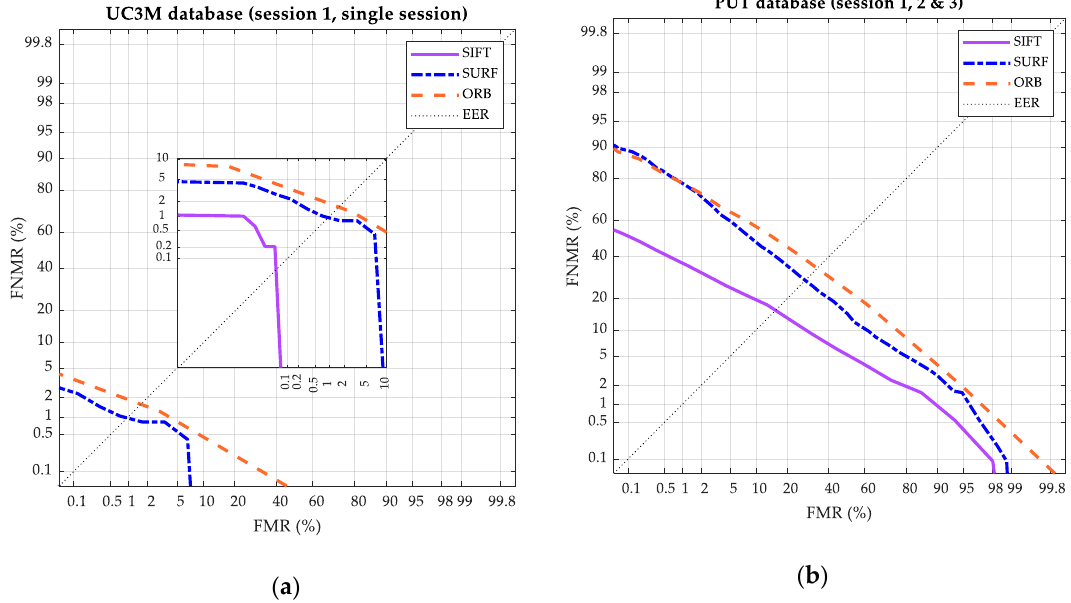
Figure 15. Results: Biometric system performance. DET curve. The FNMR percentage is represented versus the FMR percentage. The purple (continuous), blue (line-dot), and orange (line-line) curves are respectively for the SIFT ® , SURF ® , and ORB. ( a ) UC3M. ( b ) PUT.